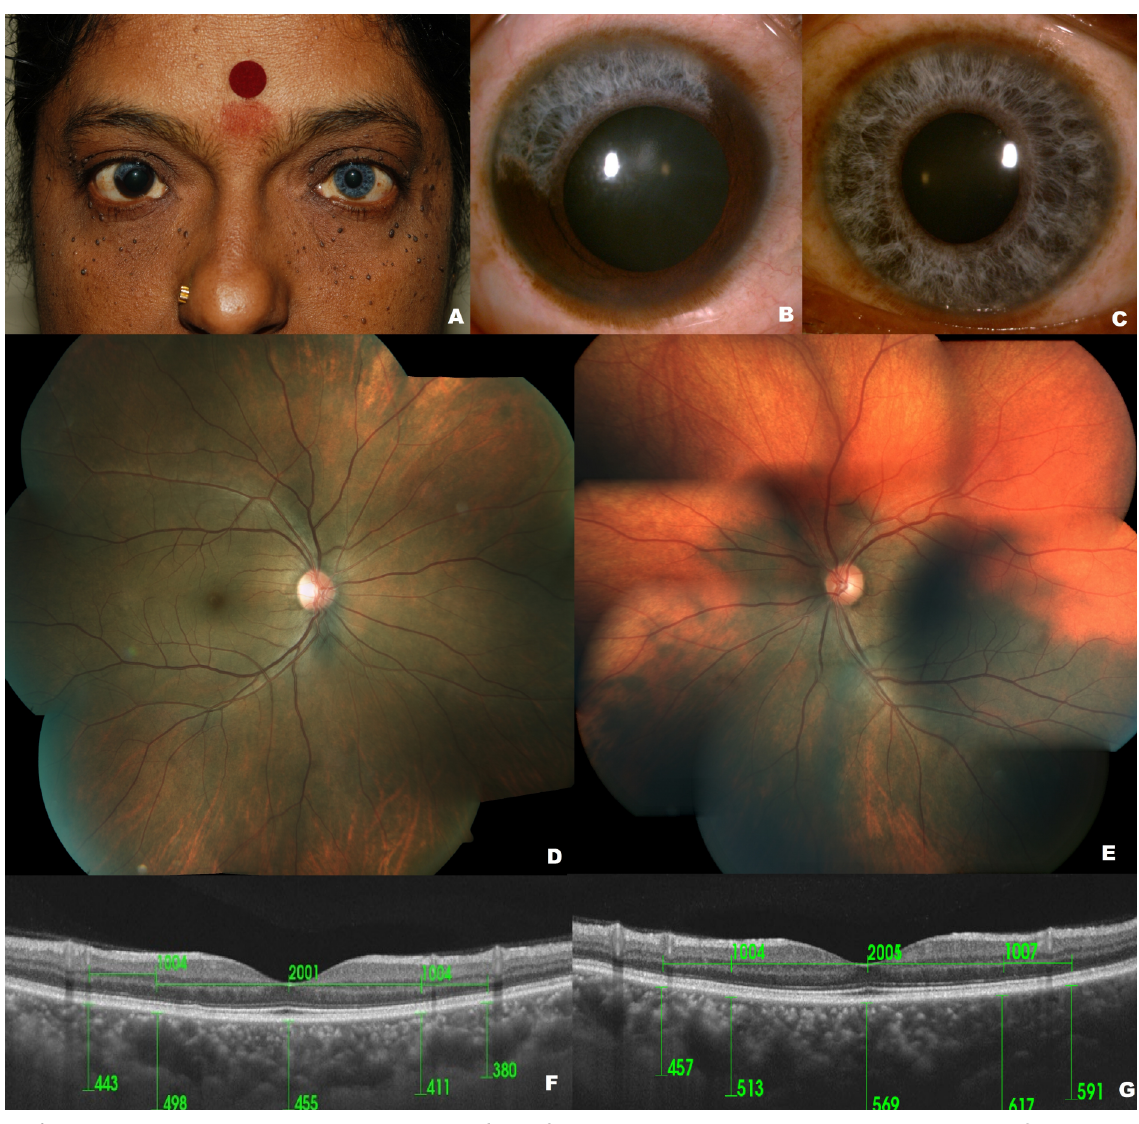
Figure 1: External photograph (A) reveals telecanthus, flare of the medial eyebrows and hypoplastic nasal alae. Slit lamp image of the right eye (B) reveals a sectoral hypopigmentation of the iris extending from 9’ o’clock meridian to 1’30” o’clock meridian. Slit lamp image of the left eye (C) reveals a complete hypopigmentation of the iris imparting it a ‘brilliant blue’ appearance. Color fundus montage of the right eye (D) reveals no area of hypopigmentation. Color fundus montage of the left eye (E) reveals a partially hypopigmented area in the superior fundus. SS-OCT of the right eye (F) reveals a subfoveal choroidal thickness of 455 µ. SS-OCT of the left eye (G) reveals a subfoveal choroidal thickness of 569 µ, a choroidal thickness of 591 µ in the pigmented fundus, and a choroidal thickness of 457 µ in the hypopigmented